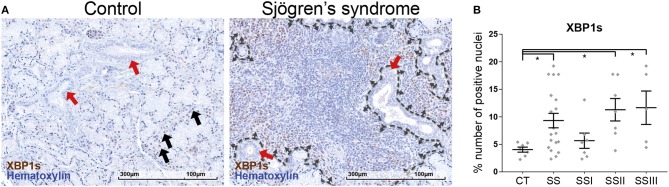
Immunohistochemical detection of XBP1s in human MSG tissues and morphometric analysis. (A) Representative images of spliced XBP1 staining in CT and SS subjects. Objective magnification: 20x. Positive signal: brown; counterstain: hematoxylin/blue. Black arrows: Positive nuclei in myoepithelial cells. Red arrows: Ductal epithelium, negative for XBP1s stain. Dashed line traces a large inflammatory lesion, with the small arrows pointing inwards, at the lesion periphery and positive cells. (B) Morphometric analysis of the percentage of positively stained for XBP1s nuclei to the total number of nuclei within the tissue sections. Data are represented as individual points for each subject, overlaid by a horizontal mean value ± SEM. Statistically significant differences indicated as * for p < 0.05.